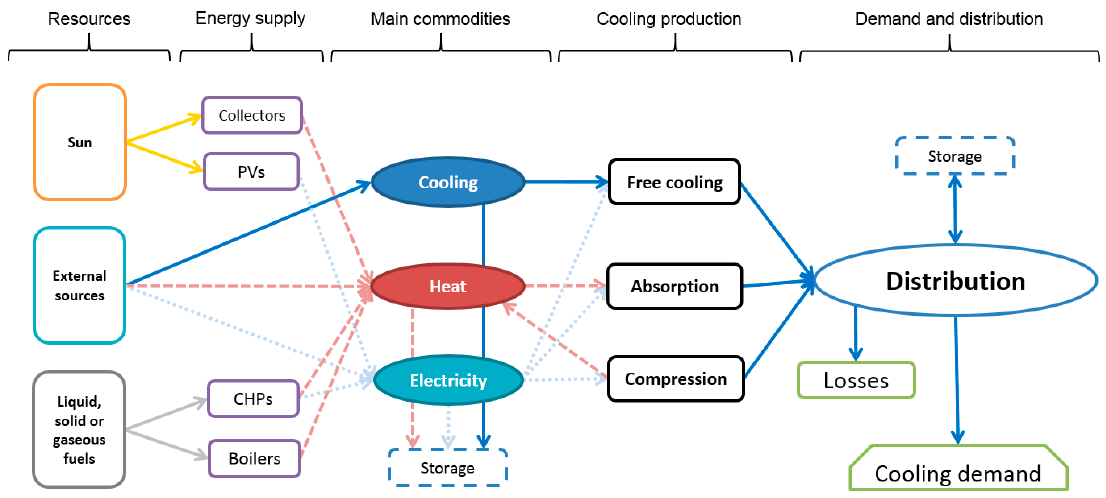
Figure 1. Structure and elements of the energy system model representing a cooling